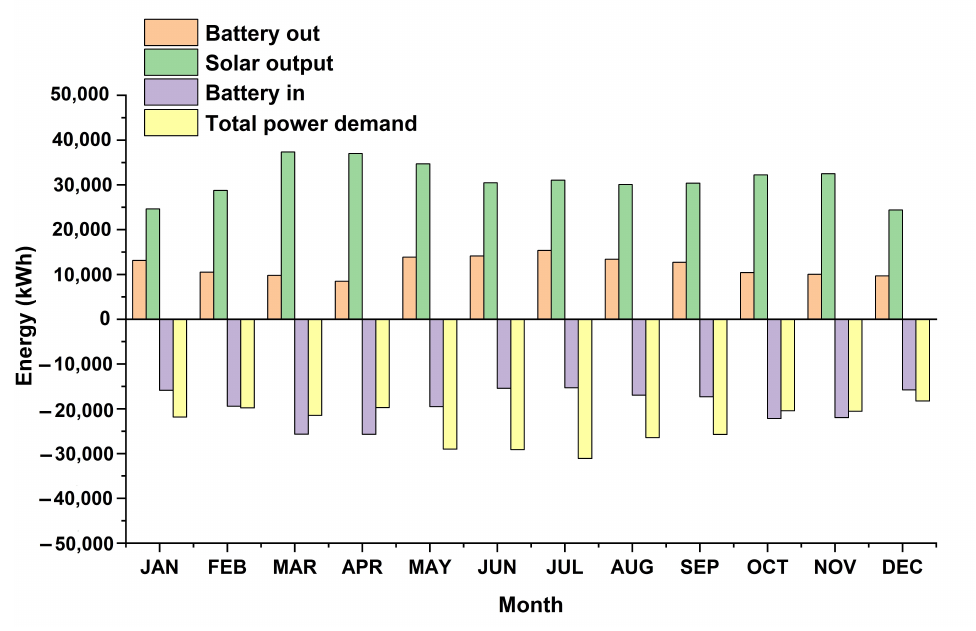
Figure 6. Energy analysis of the proposed microgrid system for one year.